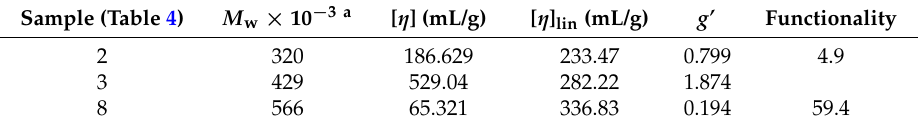
Table 6. Viscosity measurements of copolymers in THF solutions at 35 °C.